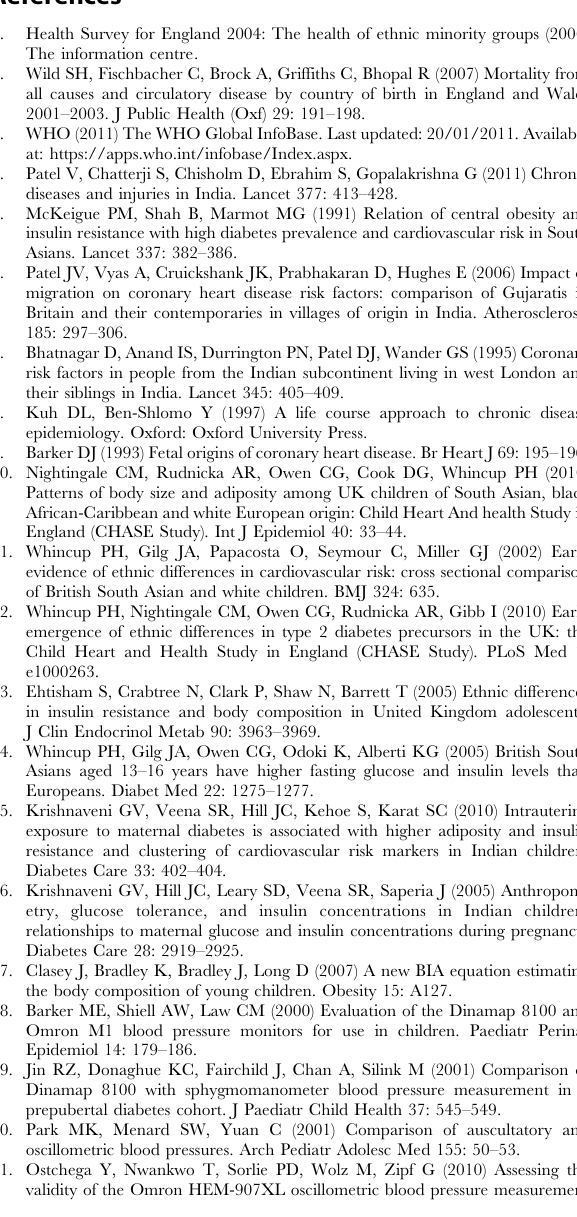
Table S1 Population differences in measures of body size/ adiposity and cardiometabolic risk markers using z-scores. Table S2 Population differences in cardiometabolic risk markers with and without adjustment for adiposity and height. Table S3 Percentage change in population differences due to adjustment for adiposity. Table S4 Laboratory differences in blood results for 26